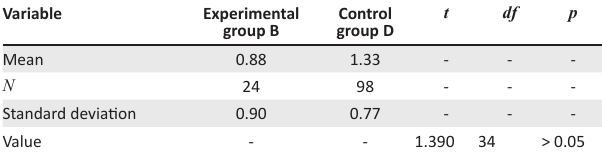
TABLE 2: Making predictions in isiXhosa post-test.